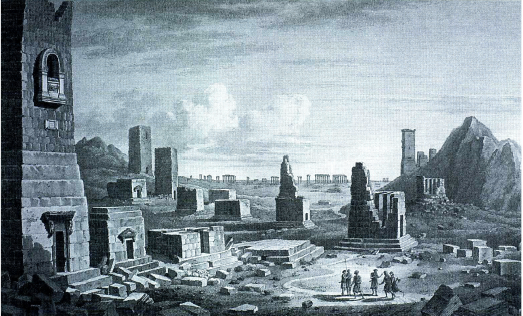
Figure 1. An old 18 th century drawing by F. Cassas depicting the Valley of Tombs in Palmyra in